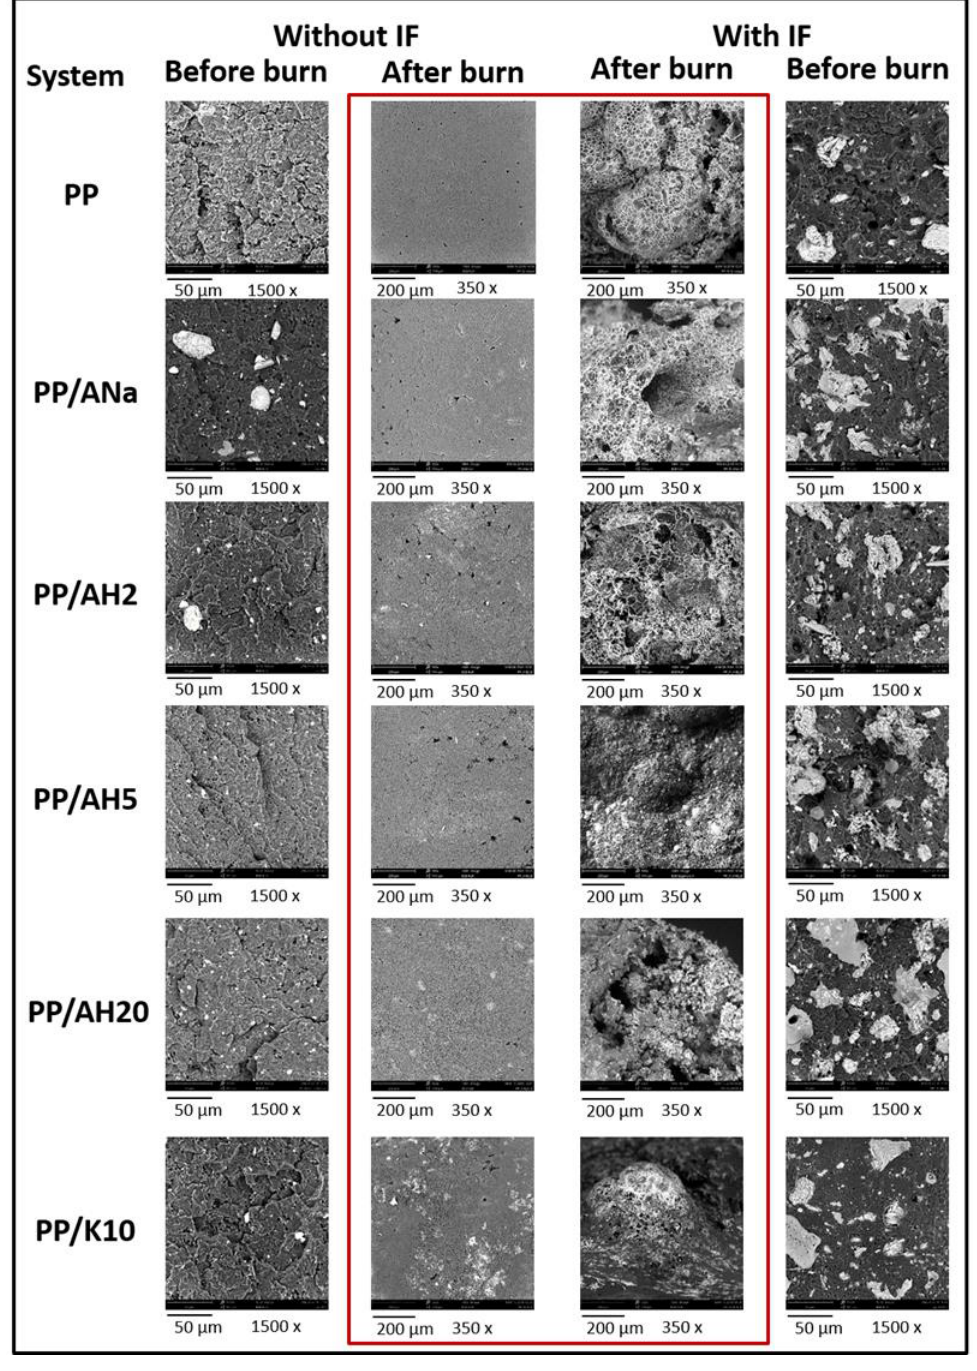
Figure 5. Scanning electron microscopy (SEM) images of surfaces of pure PP and polymeric clay mineral composites with and without intumescent formulation, before and after being burnt.